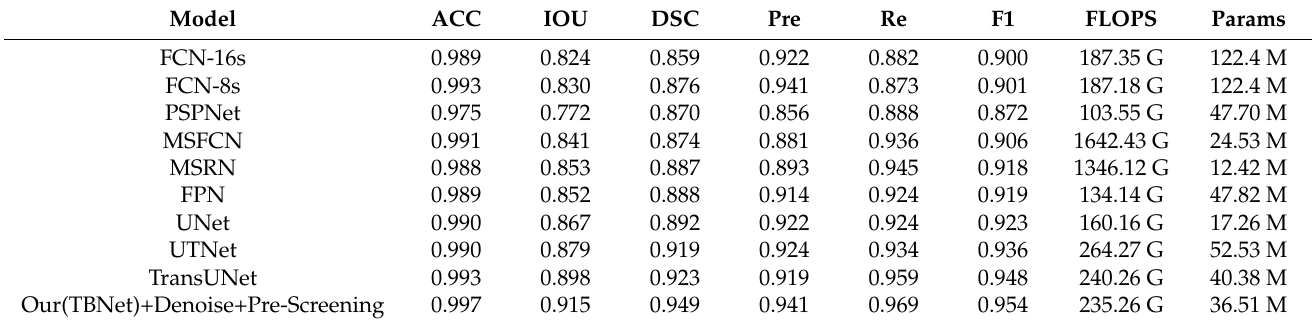
Table 4. Performance comparison of different models on the osteosarcoma